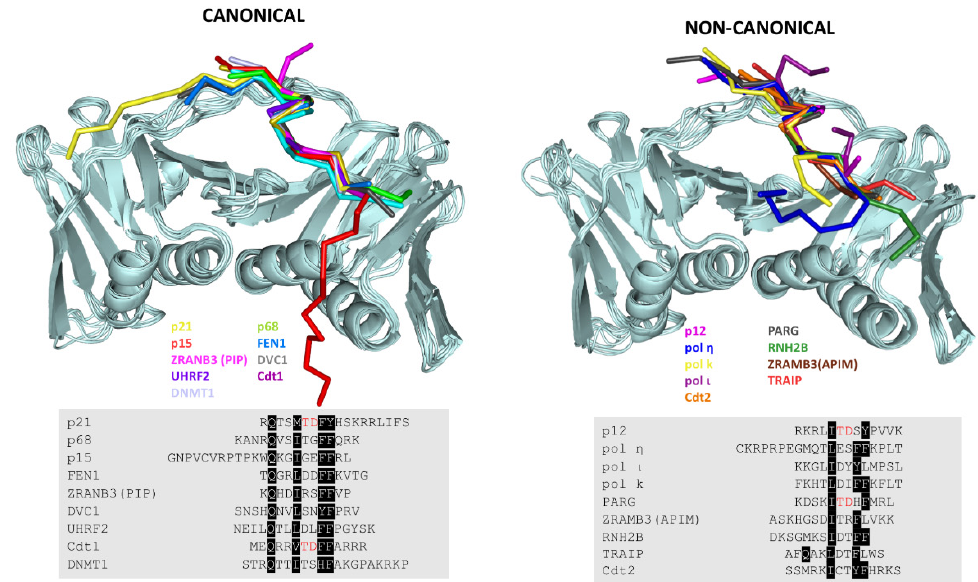
Figure 5. Upper panel: Superposition of the structures of canonical ( left ) and non-canonical ( right ) PCNA-interacting motifs bound to PCNA. The PCNA protomers are represented by ribbons, and the peptides are represented by their C α traces with different colors. Lower panel: Sequence alignment of PCNA-interacting protein fragments in crystal structures bound to PCNA. Consensus residues are highlighted in black, and the TD motif of the PCNA Interacting Protein box (PIP)-degron is depicted in red. The residues shown in the alignment are those observed in the crystal structure and do not include the terminal disordered residues present in the peptides.